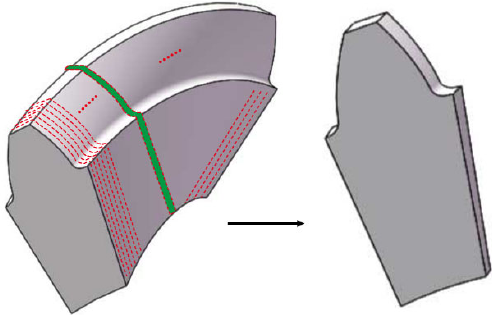
Figure 2. The schematic diagram of slicing method. When the root crack of helical gear occurs, the bending stiffness and the shear stiffness caused by radial force, and the axial bending stiffness and the axial shear stiffness caused by axial force will change. While the axial compression stiffness caused by radial force remains unchanged, and the Hertz contact stiffness remains unchanged. According to the relationship between the radius of the root circle and the base circle of the gear pair, the stiffness calculation of crack fault is discussed in two cases; only the process in case of r b 1 < r f 1 is deducted in this paper. Figure 3 is the schematic diagram of helical gear transverse face with crack fault.